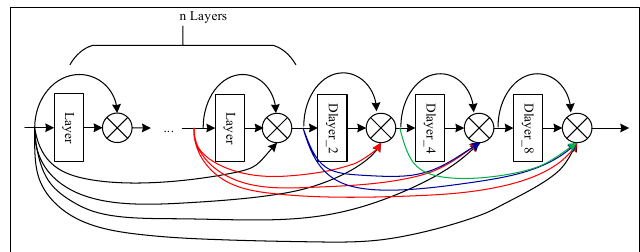
Figure 4. D-Dense block construction.